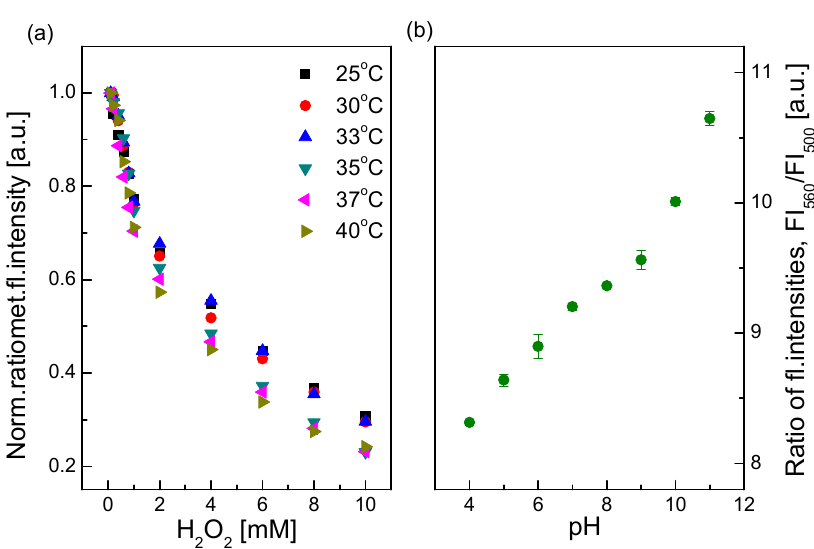
Figure 9. Response of the HRP–QD–AF membrane ( a ) when it is exposed to different H 2 O 2 concentrations with different temperatures, and ( b ) when it is exposed to 1.0 mM H 2 O 2 with various pH conditions.